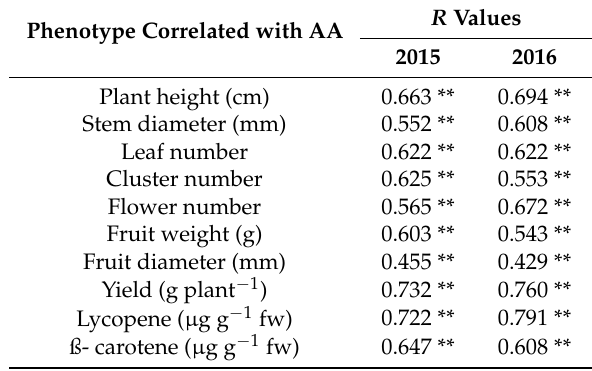
Table 1. R values for Pearson correlations between ascorbic acid levels and phenotypes of individual plants in 2015 and